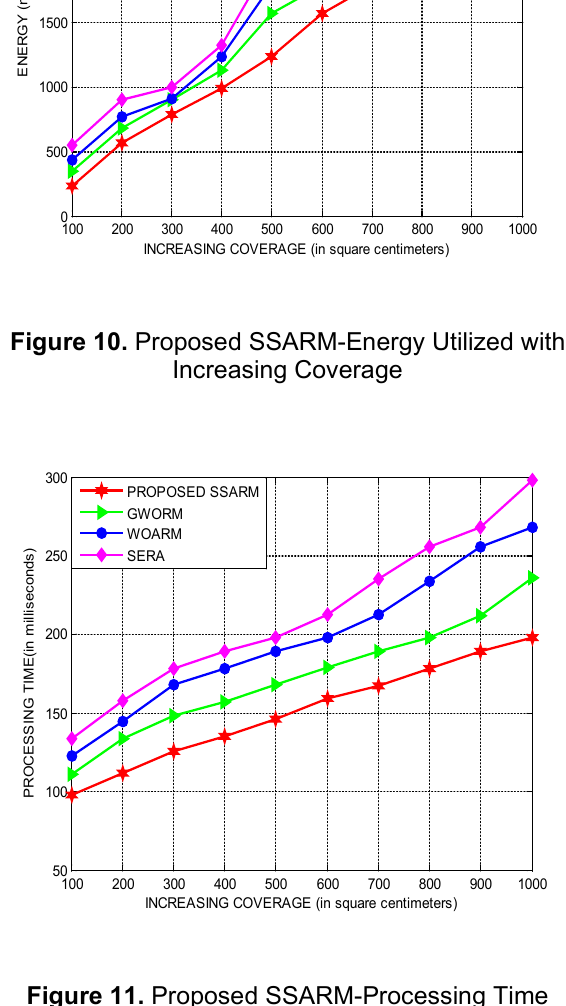
Figure 11. Proposed SSARM-Processing Time incurred with Increasing